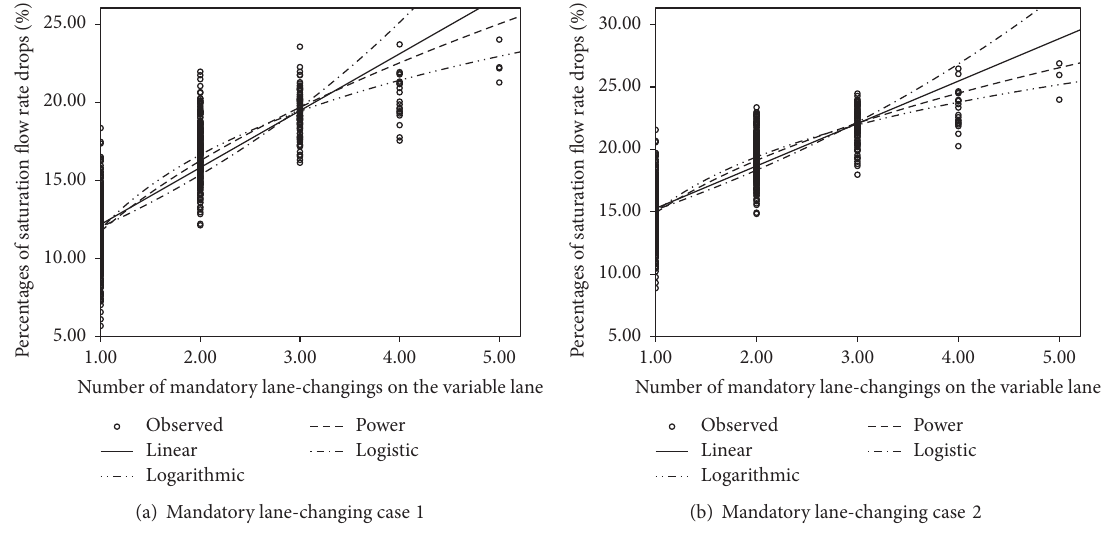
Figure 8: Regression analysis of four kinds of equations. Table 8: Regression analysis